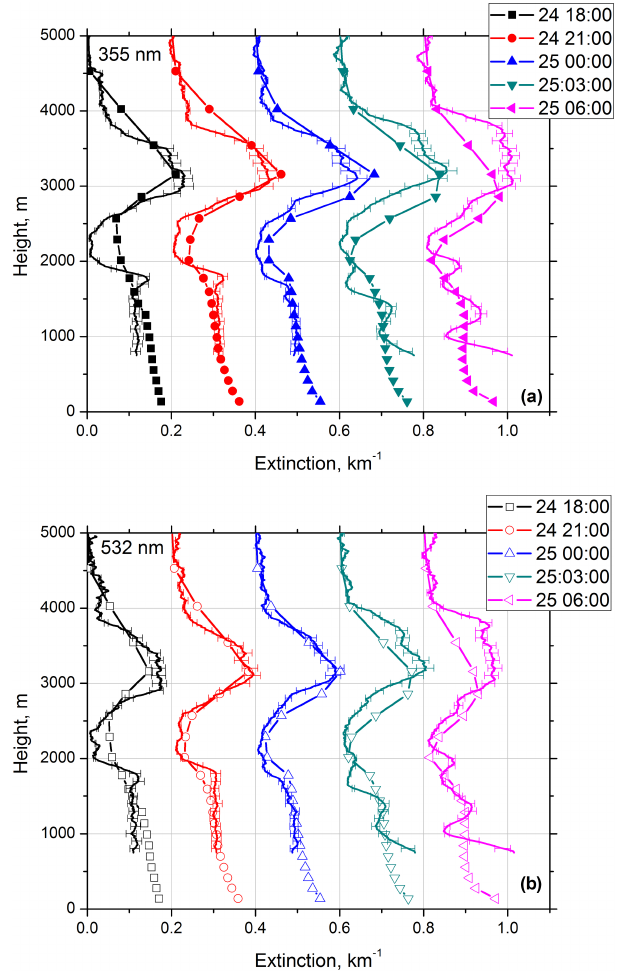
Figure 13. Comparison of extinction profiles at (a) 355nm and (b) 532nm derived from Raman lidar measurements (line) and modeled by MERRA-2 (line + symbols) on the night of 24–25 De- cember 2015. Model profiles are provided at 18:00, 21:00, 00:00, 03:00, and 06:00UTC. The lidar measurements are given for temporal intervals centered at 19:00, 21:00, 00:00, 03:00, and 06:00UTC. For each profile, 2h of measurements are averaged. The profiles are shifted relatively to each other by 0.2km − 1 .